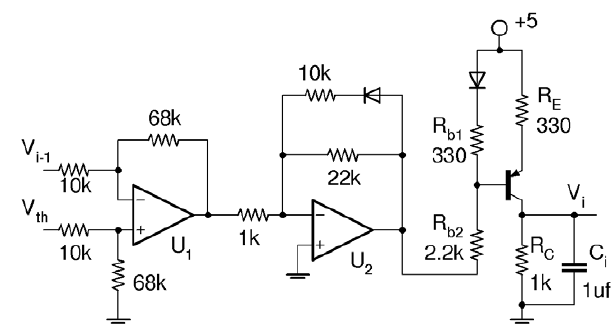
Figure 1. Electronic circuit analog of negative regulatory gene. V i -1 at the input is the concentration of inhibitory repressor. The circuit output V i is the concentration of the gene’s product. V th accounts for the binding constant of the repressor to the gene’s DNA. As inhibitor concentration V i-1 increases past V th , the voltage at the transistor base rises, turning the transistor’s collector current off, thereby stopping gene production. Op-amps are LF412, diodes are 1N4148, pnp transistor is 2N3906, and + / 2 5 V supply.